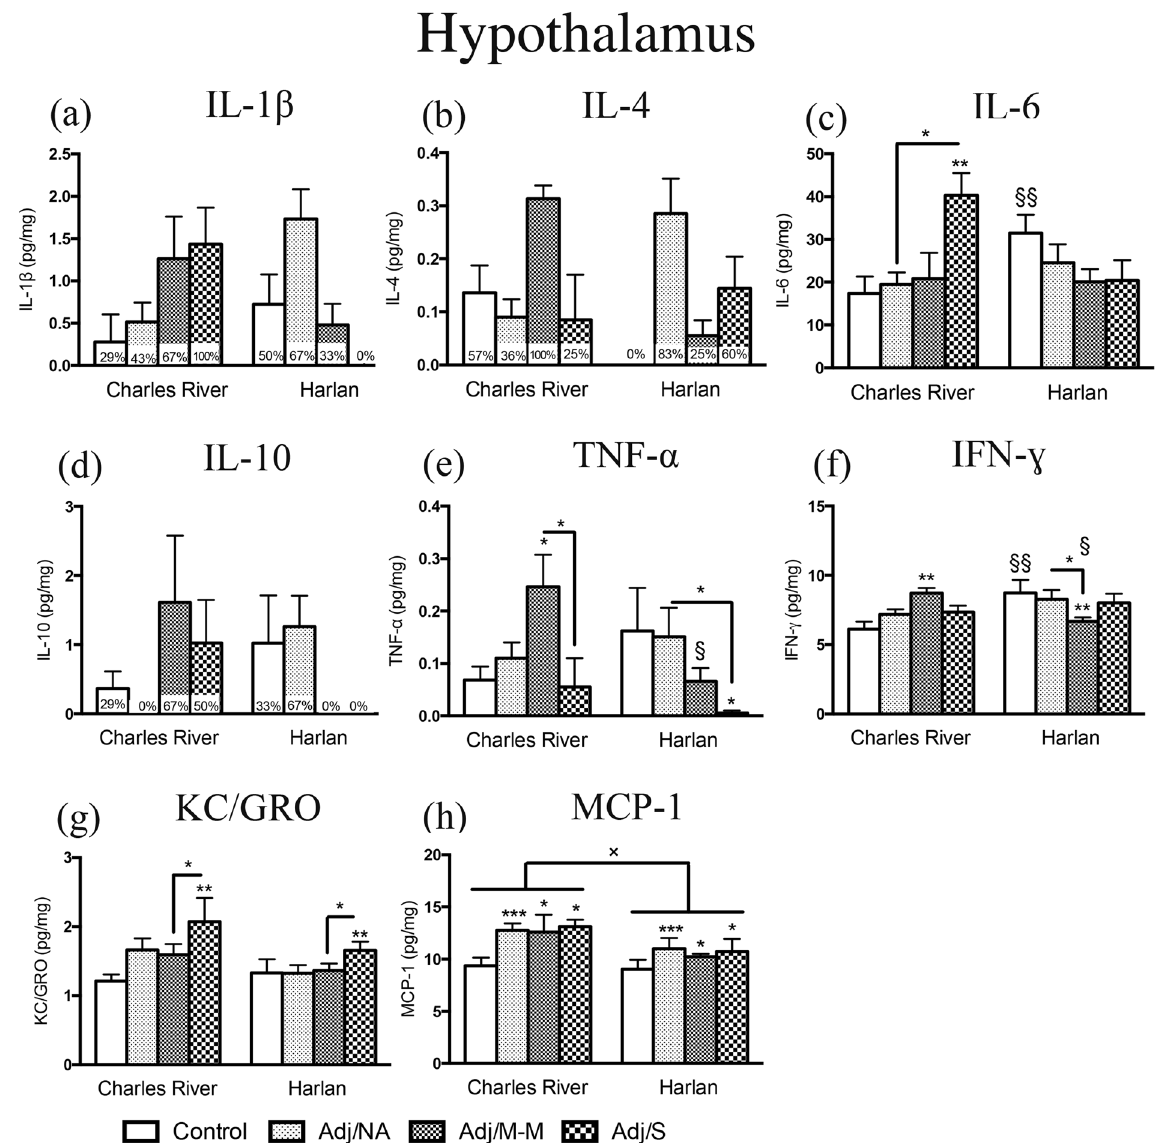
Figure. 3. Cytokine levels in the hypothalamus. Bars represent mean cytokine level ± SEM. Data are presented as pg cytokine/mg protein with statistical analysis conducted on Blom transformed (normalized) data. The presence of an asterisk ( * ) indicates a main effect of AA severity, with the comparison to the control group, unless otherwise indicated. The “ × ” symbol indicates a significant main effect of colony. The “§” symbol indicates a significant colony × AA severity interaction, with the symbol denoting a comparison between colonies, within rats of the same AA severity state. Percentages on bars indicate the percent of rats with detectable cytokine levels, (within each AA severity state) and these data (a, b, d) were not analyzed statically due to non-normal distribution. Post hoc: * /§/ × p < 0.05; ** /§§ p < 0.01; *** p < 0.001. Control: saline-injected; Adj/NA: no clinical signs of AA following CFA injection; Adj/M-M: mild-moderate AA, clinical score ≥ 1, < 8; Adj/S: severe AA, clinical score ≥